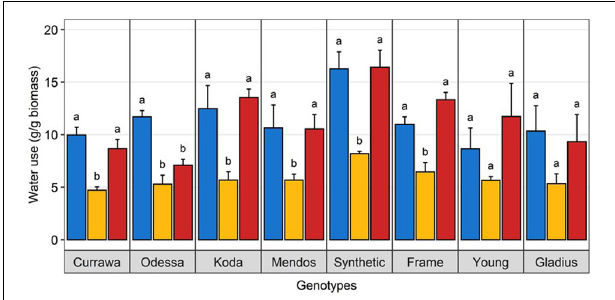
FIGURE 3 | Water use under heat stress was similar to well-watered plants. Water use per plant during the 3-day heat treatment, normalized to aboveground biomass. Plants grown in well-watered conditions (blue), drought (orange) or combined drought and heat stress (blue). Values are